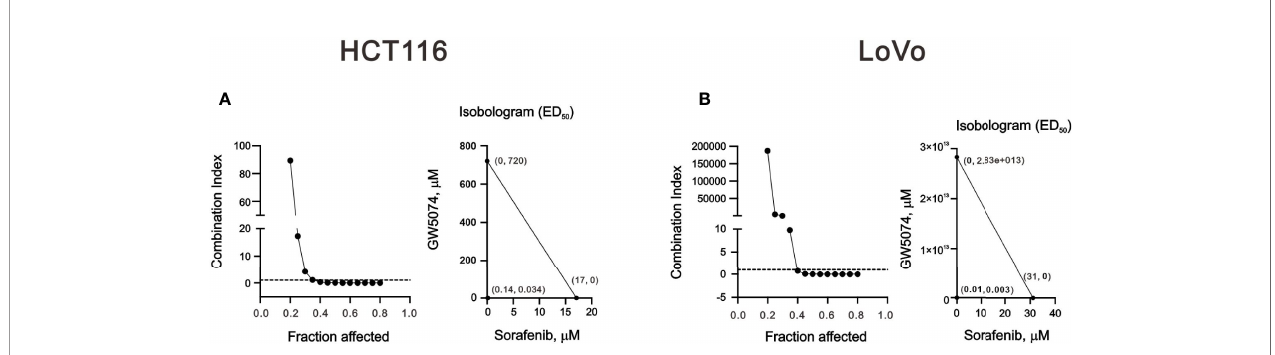
FIGURE 2 | The combination index of GW5074 and sorafenib in HCT116 and LoVo cells. HCT116 (A) and LoVo (B) cells were treated with 0, 0.313, 0.625, 1.25, 2.5, 5, 10, and 20 µM sorafenib for 24 h and 0, 0.625, 1.25, 2.5, 5, 10, 20, and 40 µM GW5074 for 24 h. Metabolic activity was measured using MTS assays. The combination index of sorafenib plus GW5074 in HCT116 (A) and LoVo (B) cells. Isobolograms (ED 50 ) of sorafenib or GW5074 were calculated using CalcuSyn